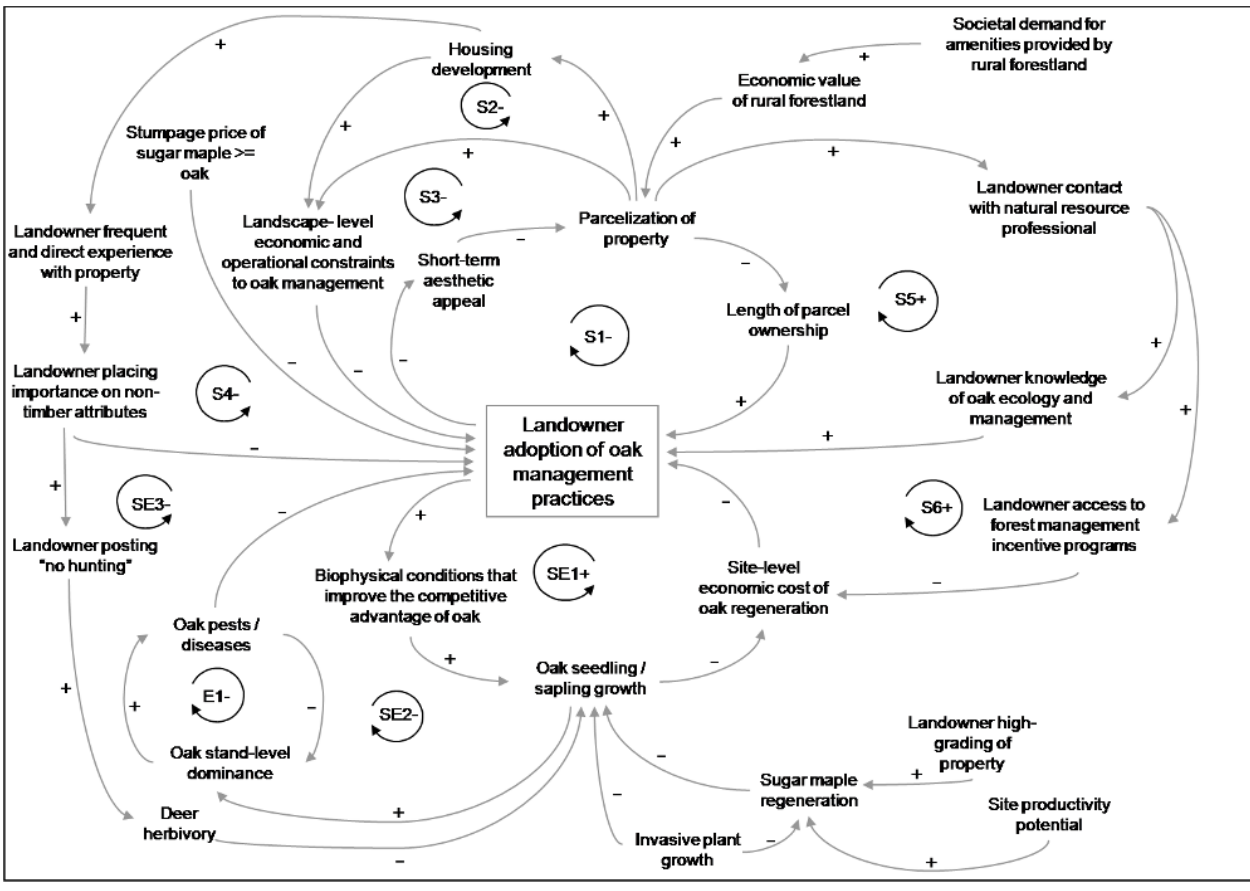
Fig. 2 . Integrative conceptual model identifying ecological, social, and economic system components that influence the oak forest social-ecological system, as identified through in-depth interviews with 32 regional natural resource professionals in the Driftless Area of the Midwest. We identify feedback loops as primarily ecological (E), socioeconomic (S), or social-ecological (SE) in nature, with -/+ indicating the direction of the relationship for each component connection and feedback